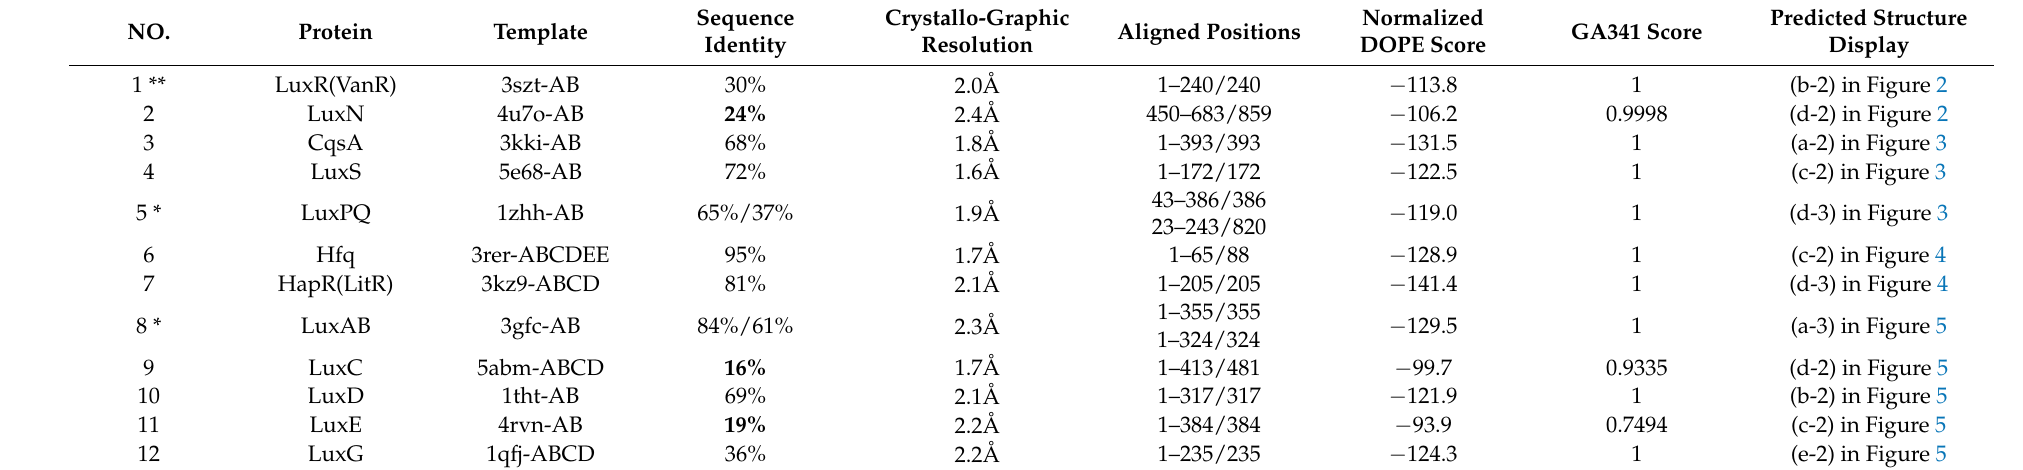
Table 2. Modeling of protein oligomers in the QS pathway of